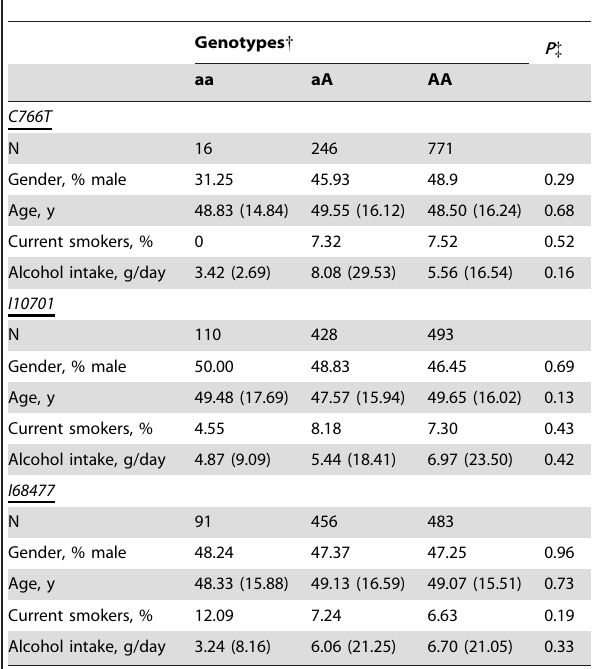
Table 1. N, mean age (standard deviation) and percentage of males and ApoE e 3 carriers, in the GOLDN study population by LRP-1 genotype group.